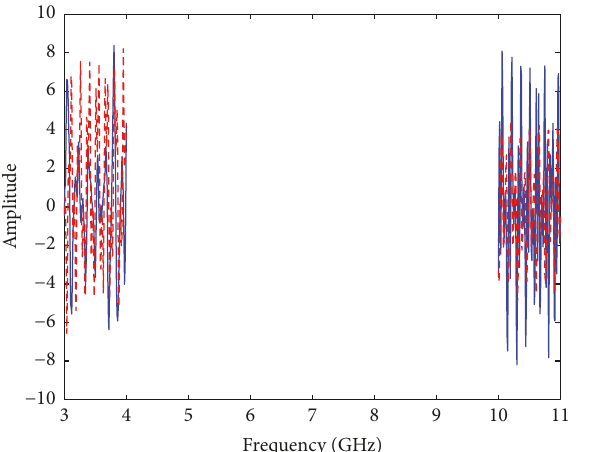
Figure 4: Two subband data sets (blue solid lines denote the real coherent subbands. Red dash line denotes the measured incoherent subbands in the condition that target is moving).